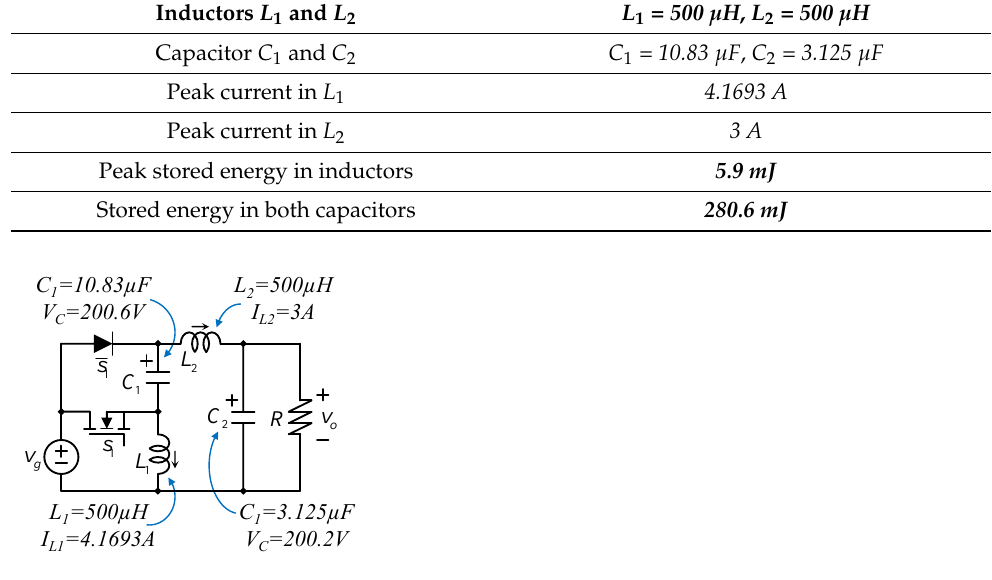
Table 3. Proposed converter results.